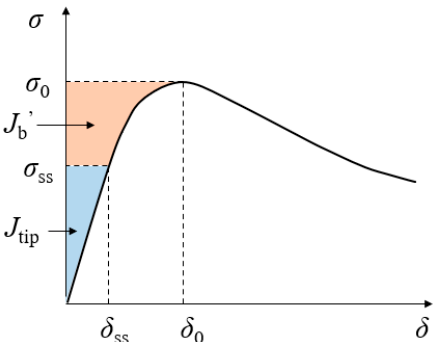
Figure 3. Illustration of the stress-crack opening curve for HPFRCC. The orange area represents the complementary energy (J b ’), and the blue area represents the crack tip toughness (J tip ).